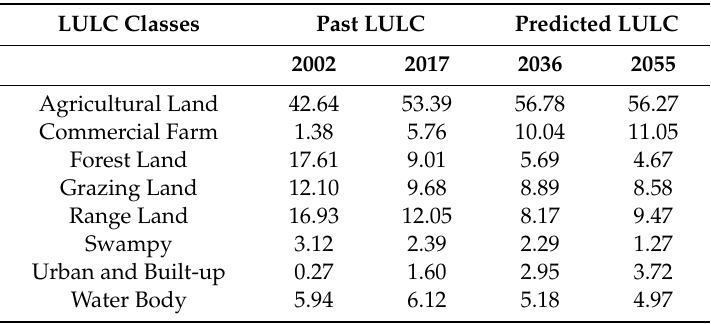
Table 2. Percentage (%) of LULC in Finchaa